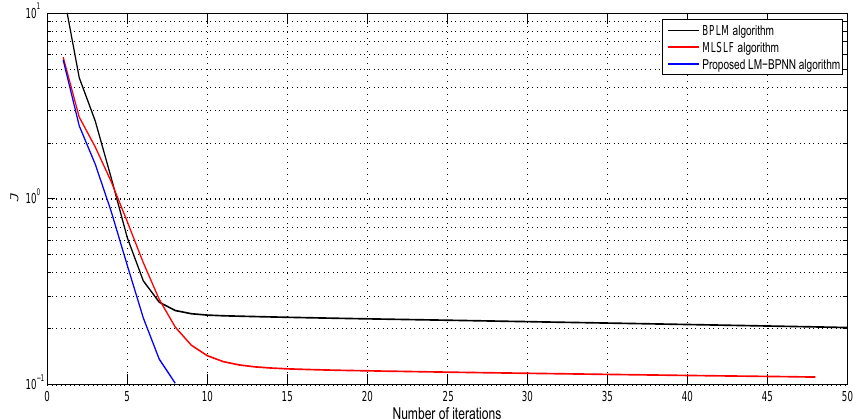
Figure 2. Evolution of the cost function of different